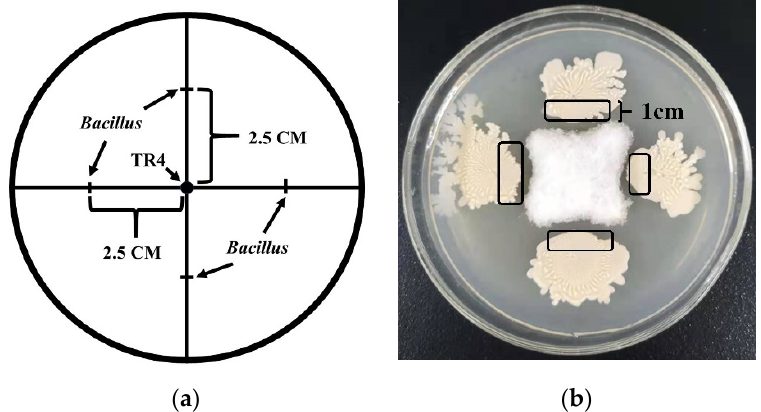
Figure 1. The schematic and sampling location of dual-culture test. ( a ) The sampling location for dual-culture test. The arrow points are shown to be the inoculation sites of TR4 and Bacillus . ( b ) The sampling location for dual-culture test. Five Bacillus strains and TR4 were single or dual cultivated, respectively, using dual-culture test, and samples were taken after 7 days when TR4 mycelia filled the whole petri dish. Sampling positions were circled in black ink—about 1 cm wide, and single-cultures of each strain used as controls.